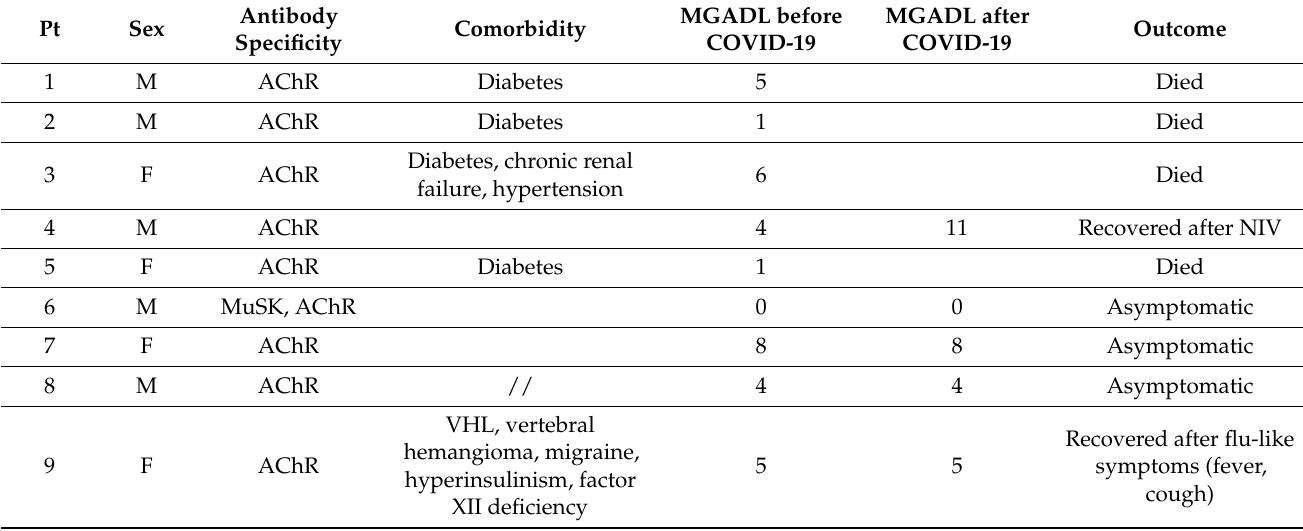
Table 2. Demographic characteristics and medical history of MG patients with SARS-CoV2